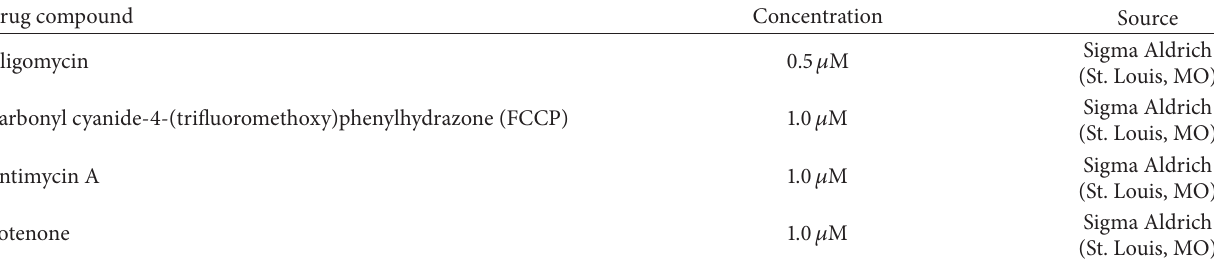
Table 1: Drug concentrations used for Seahorse XFe96